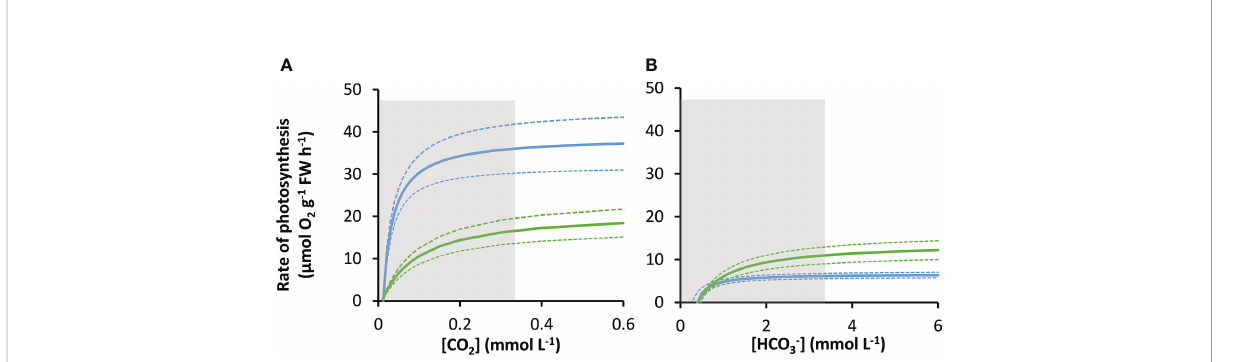
FIGURE 2 Modelled responses of photosynthesis by P. oceanica and Z. marina to inorganic carbon. Response of P. oceanica (blue) and Z. marina (green) to concentration of CO 2 (A) and HCO − 3 (B) . The bold solid line represents the mean and the upper and the lower dotted lines represent the upper and lower standard deviation. The concentration range of the measurements used to construct the models is indicated by the grey shaded